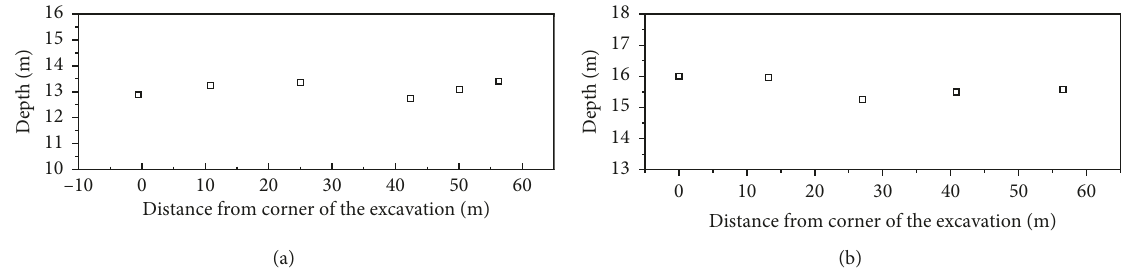
Figure 12: Depths of neutral points of Fengqi Road excavation. (a) Side far from excavation. (b) Side near excavation.